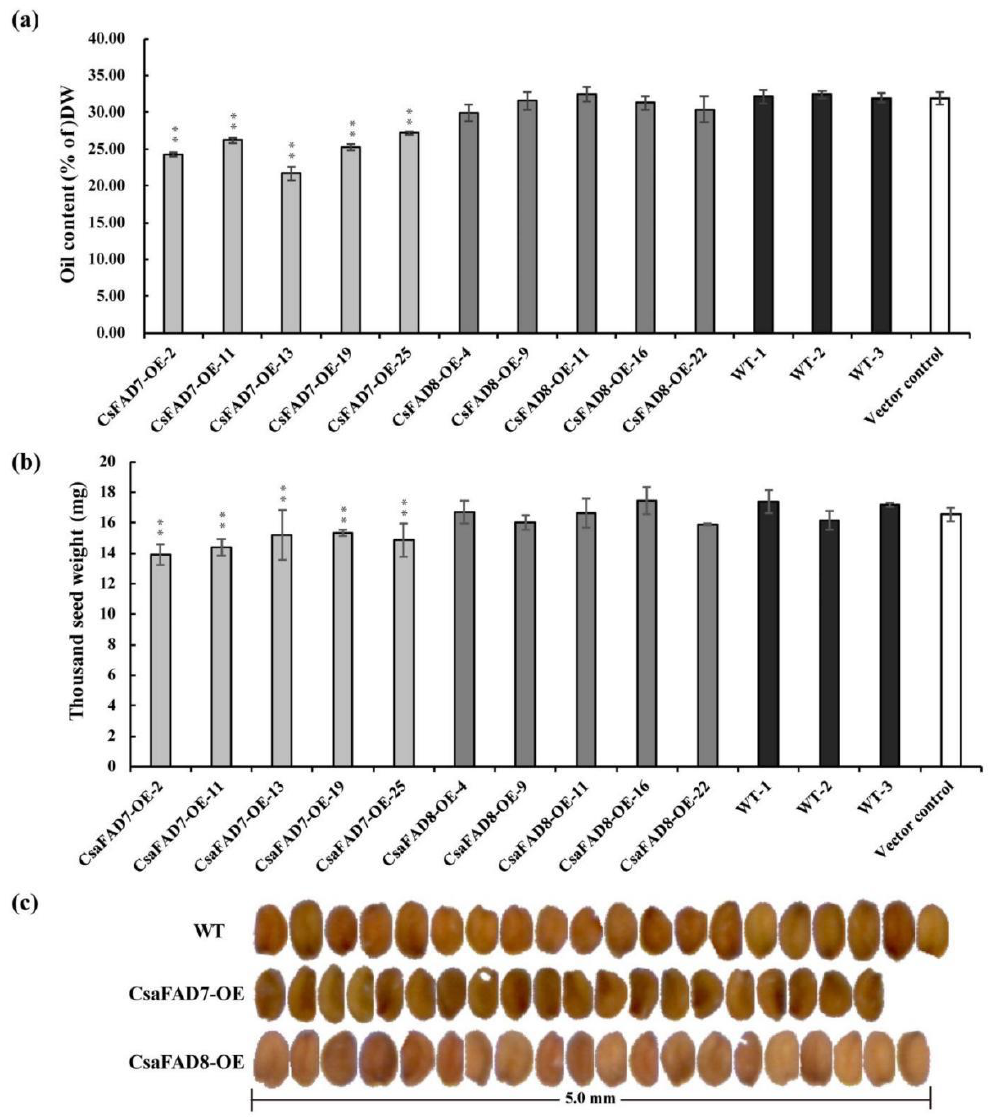
Figure 7. Oil content and seed morphology of CsaFAD7 and CsaFAD8 transgenic lines. ( a ) Oil content of CsaFAD7 and CsaFAD8 overexpression lines dry seeds. DW, dry weight. T3 generation dry mature seeds were collected for GC analysis with 5 repeats for each line. Asterisk represents a significant difference ( p < 0.01, n = 5). ( b ) Thousand seed weight of CsaFAD7 and CsaFAD8 overexpression lines dry seeds. The dry mature seed size was measured with 5 repeats for each line. Asterisk represents a significant difference ( p < 0.01, n = 5). Vector control, pBinGlyRed3 transgenic lines under wild type background as control. ( c ) Seed appearance of CsaFAD7 , CsaFAD8 overexpression lines, and WT dry